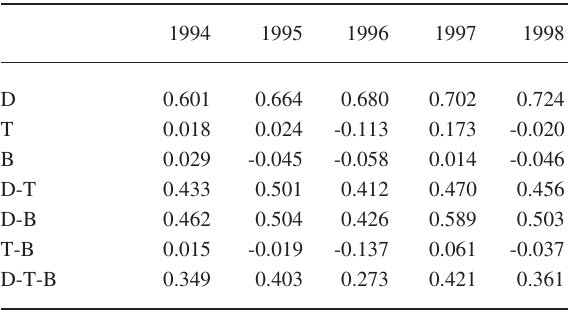
T ABLE 3. – HARMONIC correlation coefficient (weighed Spear- man) between the numerical cephalopod species matrix and physi- cal parameters: depth (D), temperature (T) and bottom type (B); between the numerical cephalopod matrix and pairs of physical parameters: depth-temperature (D-T), depth-bottom type (D-B) and temperature-bottom type (T-B); and between the matrix and all of parameters: depth-temperature-bottom type